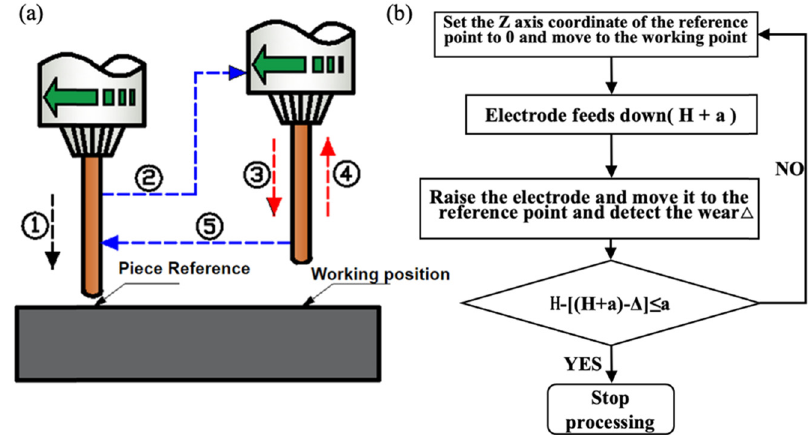
Figure 2: ( a ) The diagram of electrode movement and ( b ) the chart of work fl